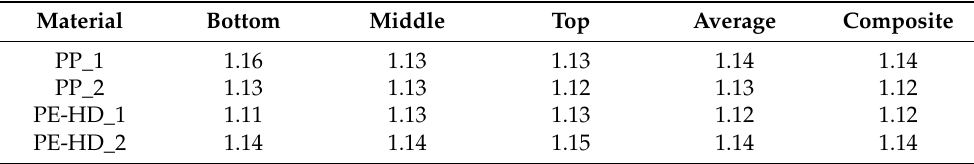
Table 5. List of the compaction factors of the four